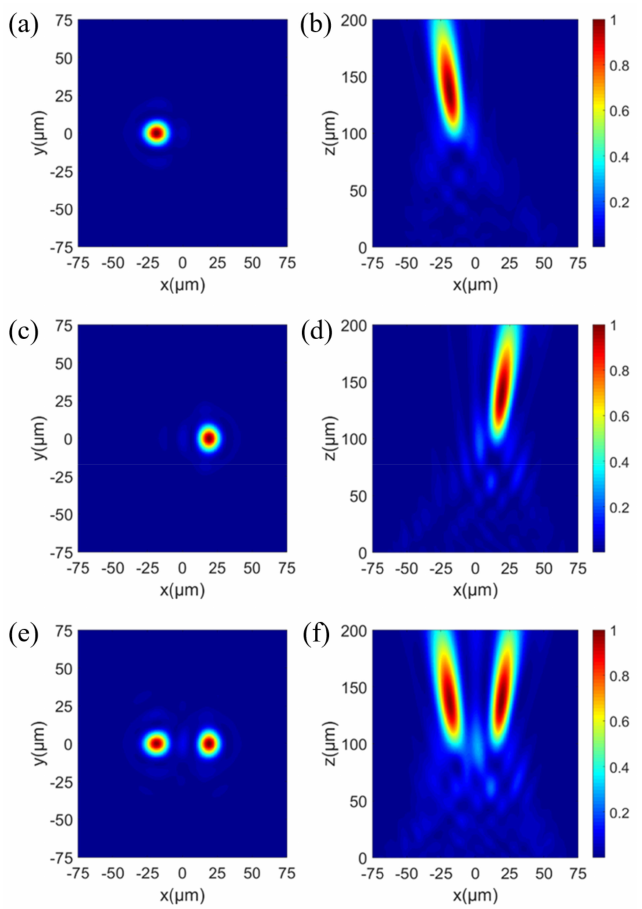
Figure 4. The normalized distribution of the square of the electric field intensity when X − polarized light, Y − polarized light and 45 ◦ polarized light successively pass through the OLPM: ( a , c , e ) X − Y plane; ( b , d , f ) X − Z